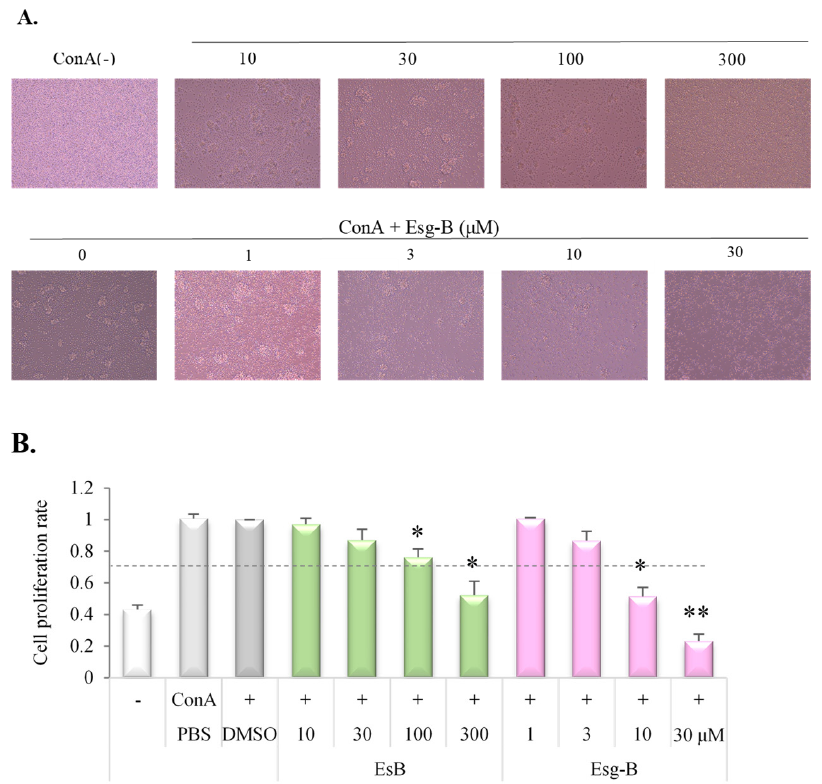
Figure 3. Inhibition of ConA blast proliferation by EsB/Esg-B using WST assay. ( A ) Photographs show ConA blast lymphocyte and the inhibition by EsB/Esg-B. ( B ) Expression of cell proliferation ratio of ConA blasts without and with EsB/Esg-B addition was determined by the WST assay. Splenocytes were treated with 0.1% DMSO or the respective concentrations of EsB/ Esg-B for 1 h, then stimulated with ConA (1 μ g/mL) for 48 h. Results were normalized to the optical density of the culture by ConA alone. Data represent five independent experiments, and each bar is expressed as mean ± SEM. *: p < 0.05, **: p < 0.01, significantly different from the control (ConA alone). EsB: Esculeoside B; Esg-B: Esculeogenin B. The grey dotted line shows about 50% of ConA-induced elevated responses.